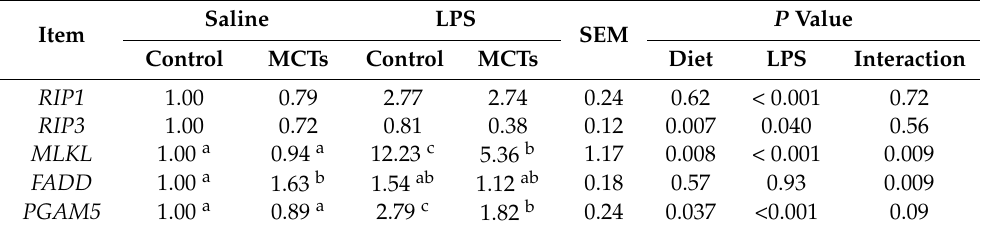
Table 3. Effect of medium-chain triglyceride (MCT) supplementation on mRNA expression of key signaling molecules in necroptosis after 4-h LPS challenge in pigs * ,† .